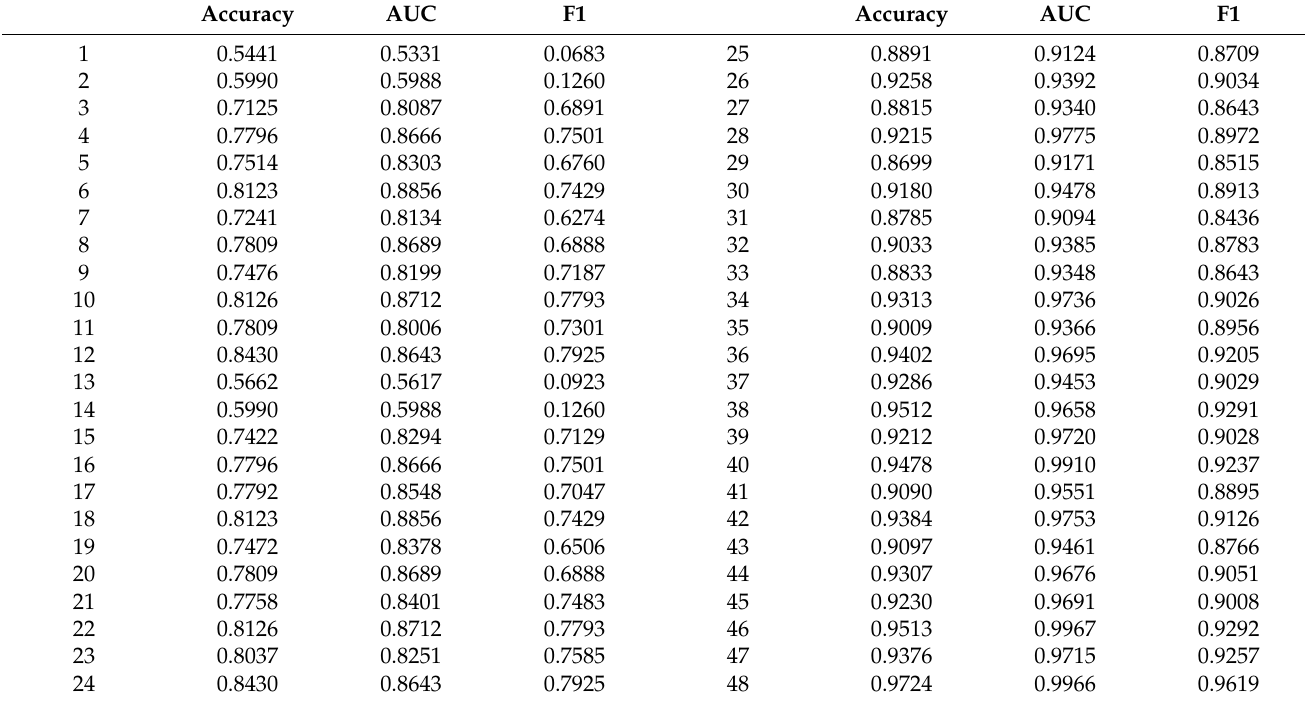
Table 8. KPIs of the proposed binary classification